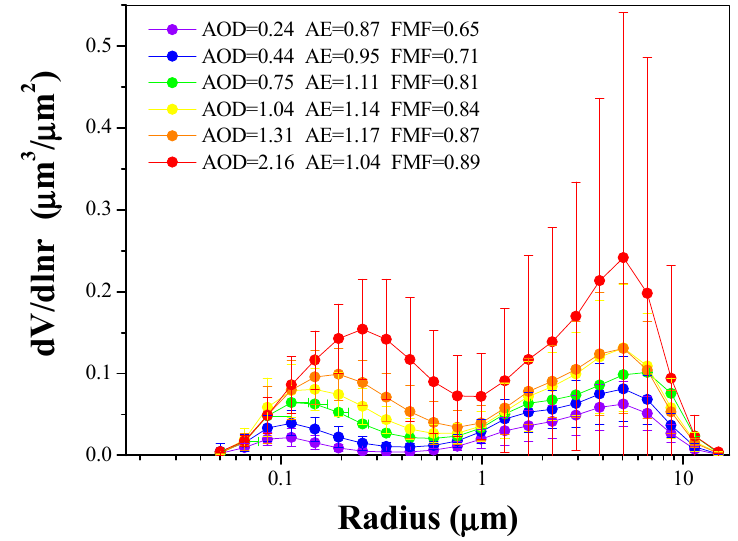
Figure 4. Relationship between volume particle size distribution and AOD in Xi’an. The average of VPSD for each bins of AOD ( ≤ 0.3, 0.3–0.6, 0.6–0.9, 0.9–1.2, 1.2–1.5, >1.5) are marked in different colors from purple to red, with error bars indicating the standard deviation. The mean values of AOD, AE, and Fine mode fraction (FMF) for the given bin are also presented in the legend.